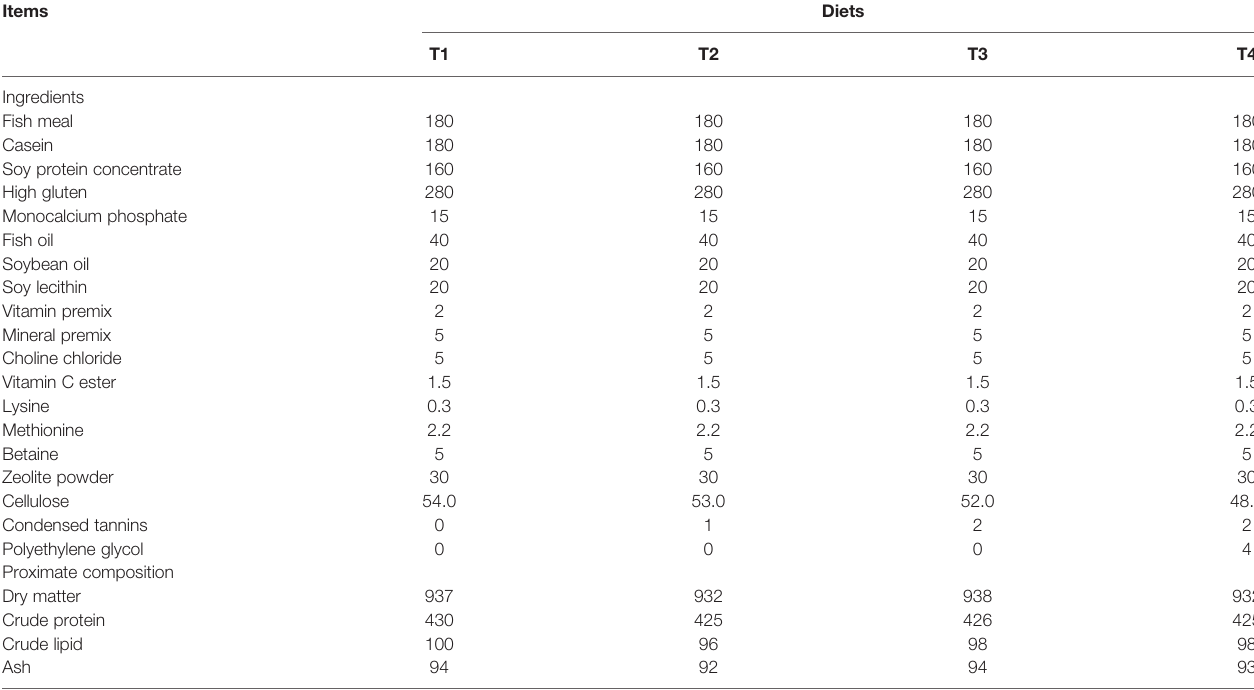
TABLE 1 | Ingredients and proximate composition (g/kg DM) of experimental